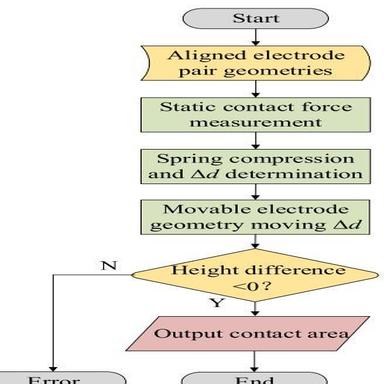
Flowchart of contact area measurement.